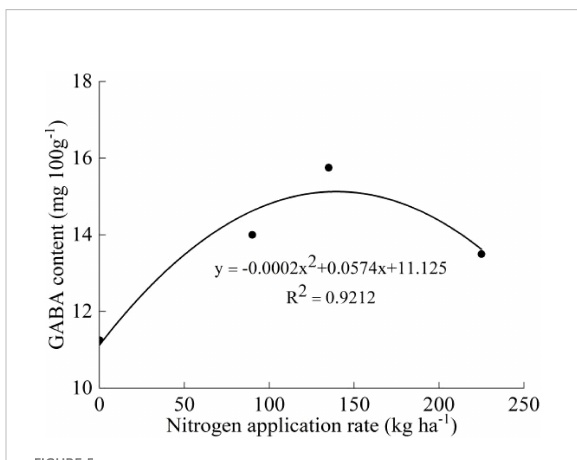
FIGURE 5 Relationship between Koshihikari GABA content and nitrogen application